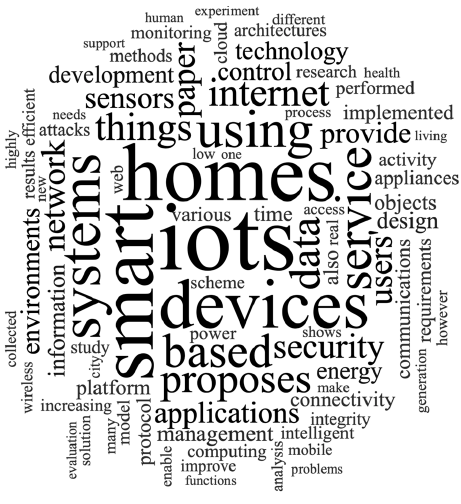
Figure 4. Word cloud top 100.